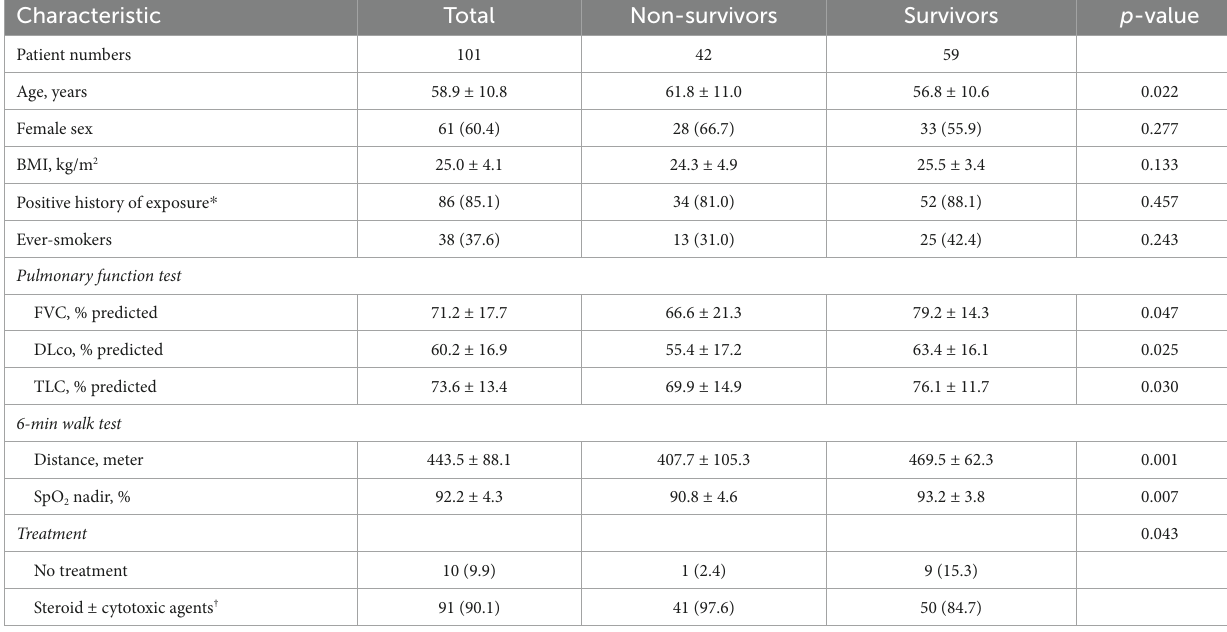
TABLE 1 Comparison of baseline characteristics between the non-survivors and survivors among patients with fibrotic HP.